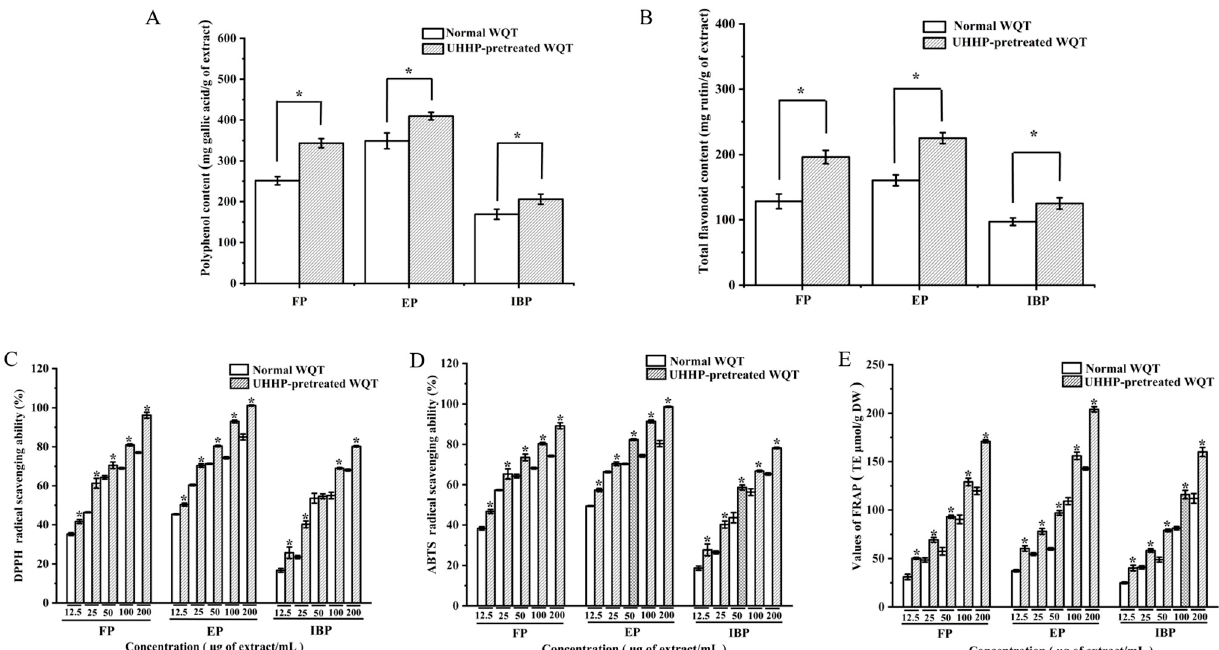
Figure 1. The contents of total phenolics and total flavonoids as well as their antioxidant activities of free, esterified, and insoluble-bound phenolic fractions from normal and UHHP-pretreated White Que Zui tea (WQT). ( A ): Total phenolic content; ( B ): total flavonoid content; ( C ): DPPH radical scavenging activity; ( D ): ABTS radical scavenging ability; ( E ): iron reduction antioxidant capacity (FRAP). All the values are expressed as mean ± SD (n = 3). “*” means significant differences between the same fractions from the normal and UHHP-pretreated WQT ( p < 0.05). FP and UFP: free phenolic fraction from normal and UHHP-pretreated WQT; EP and UEP: esterified phenolic fraction from normal and UHHP-pretreated WQT; IBP and UIBP: insoluble-bound phenolic fraction from normal and UHHP-pretreated WQT.